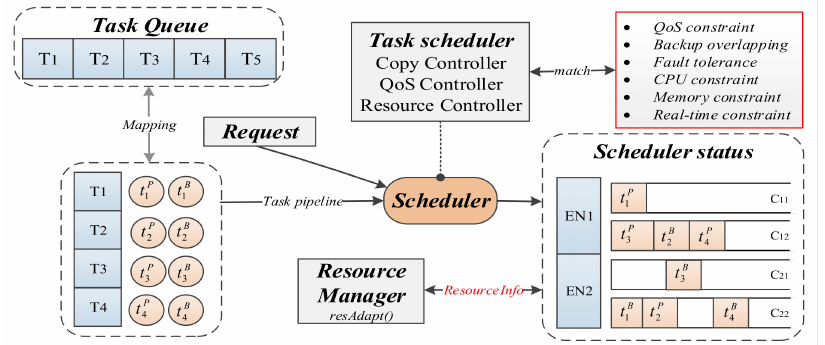
Figure 4. The framework of FASDQ (Fault-tolerant Adaptive Scheduling mechanism with Dynamic